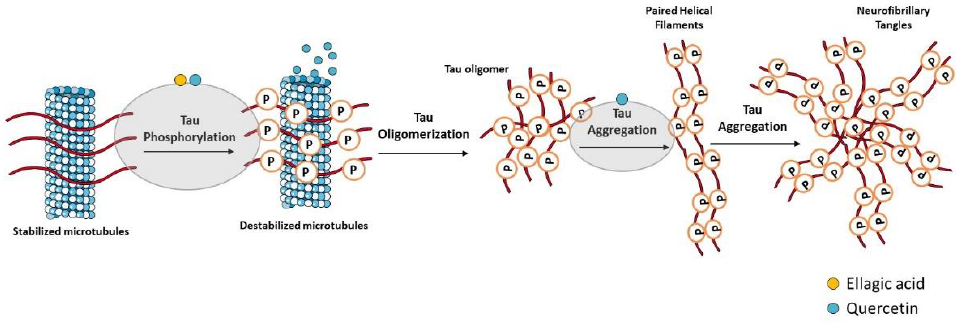
Figure 3. Effect of compounds obtained from E. globulus leaves on tau aggregation and formation of neurofibrillary tangles (NFTs) in AD. Irregular phosphorylation of tau proteins destabilizes mi- crotubules, leading to the formation of insoluble tau oligomers, which then accumulate to generate protomers. Then, two twisted protomers originate paired helical filaments, which after aggregation lead to the formation of NFTs. These intracellular structures are involved in synaptic and neuronal dysfunction, thus contributing to cognitive decline in AD.